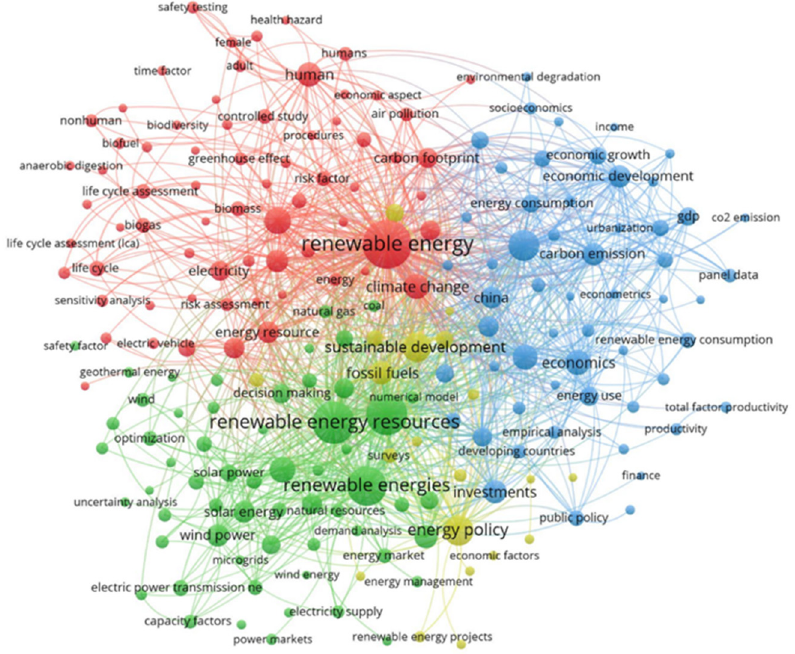
Figure 3. The network map of bibliometric analysis of RE development (created by authors, based on data from Scopus).